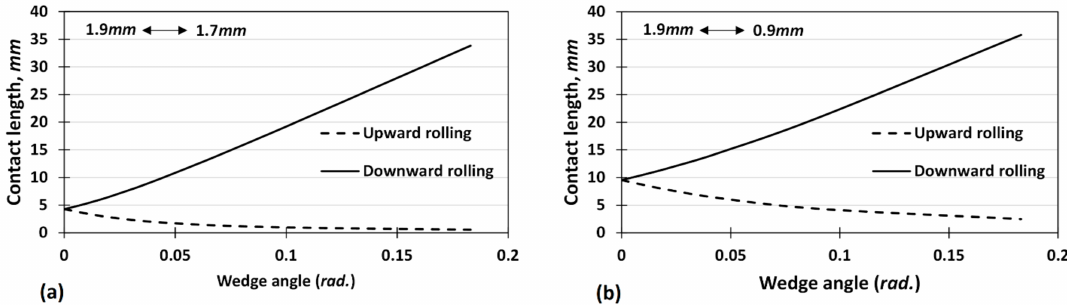
Figure 9. Dependency of contact length during upward and downward rolling for ( a ) absolute thickness reduction of 0.2 mm and ( b ) absolute thickness reduction of 1